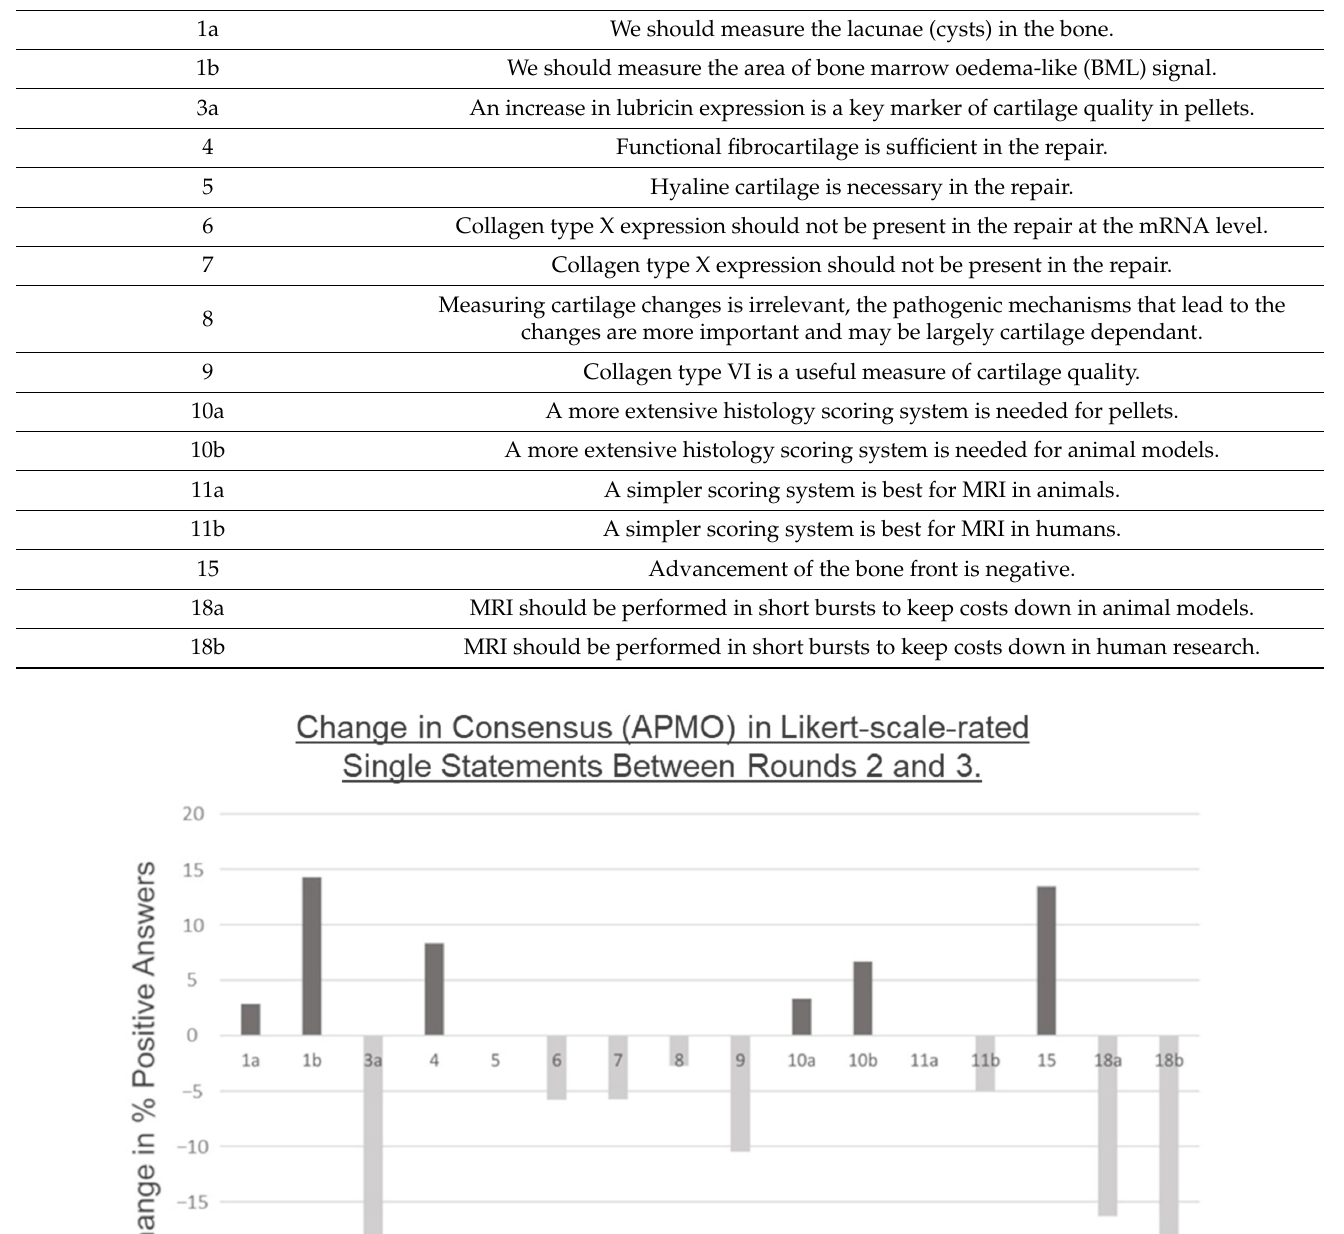
Table 8. A summary of the Likert-scale-rated single statements that did not reach threshold consensus over the course of this Delphi study.